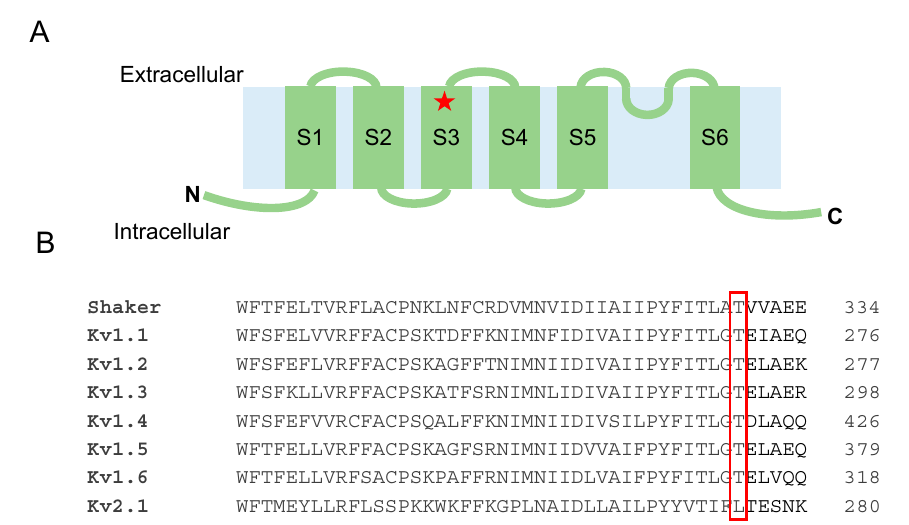
Figure 2. ( A ) Position of the T268K substitution in the Kv1.1 channel structure. ( B ) Amino acid alignment of Kv1 and Kv2.1 channels.